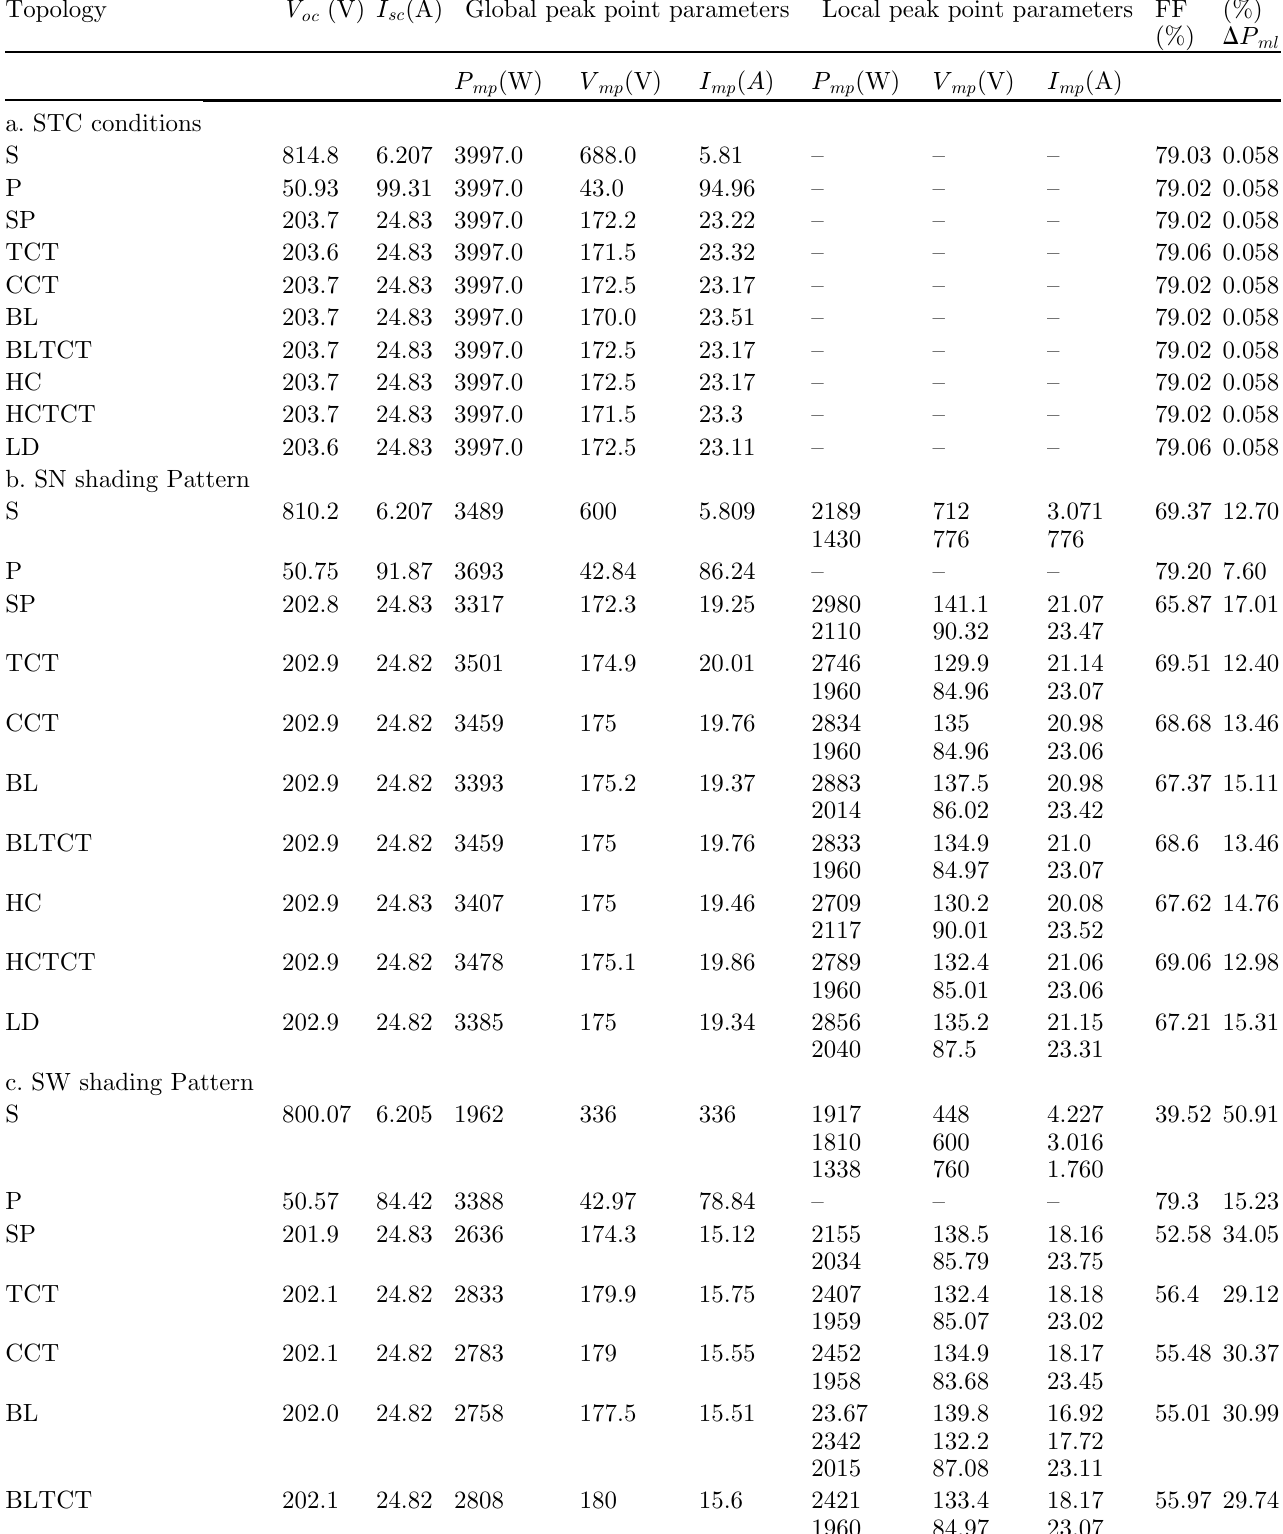
Table 3. PV modules con fi gurations parameter variations under shading conditions.